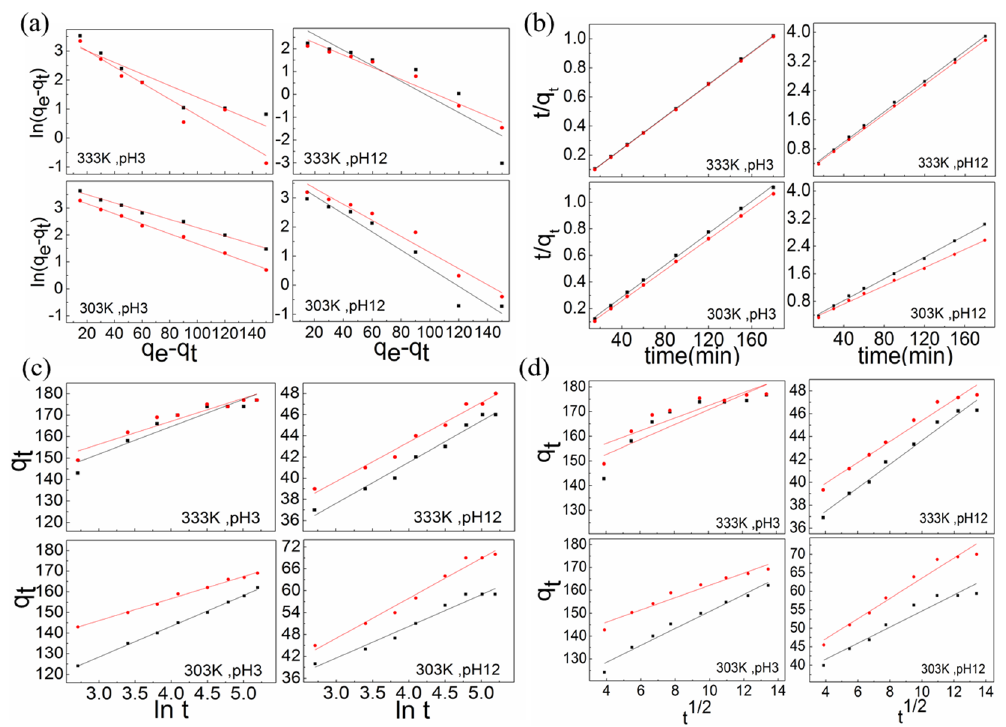
Figure 8. Adsorption kinetics models of the two adsorbents at different temperatures: ( a ) pseudo- first-order model; ( b ) pseudo-second-order model; ( c ) Elovich model; ( d ) Weber–Morris model ( ■ CS, • ● CSGO).